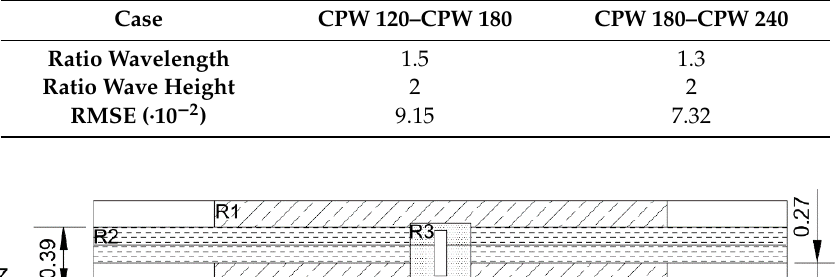
Table 2. Root Mean Squared Error (RMSE) calculated using the results of the rotation angles.